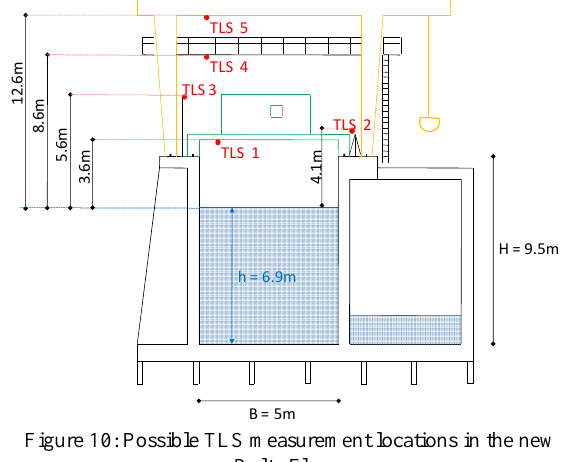
Figure 10: Possible TLS measurement locations in the new Delta Flume